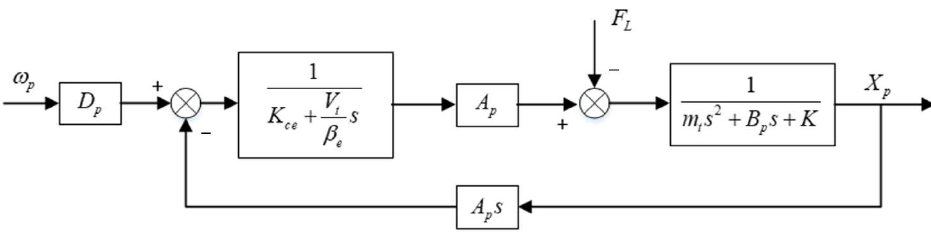
Figure 12. Speed loop closed-loop Bode diagram. ( a ) Amplitude diagram. ( b ) The phase diagram.